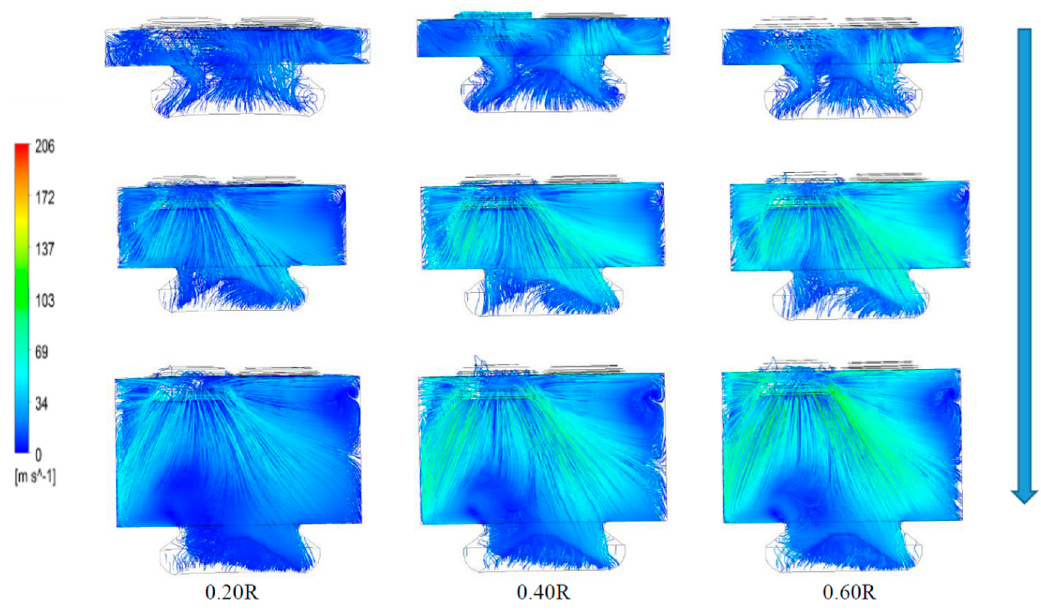
Figure 12. The computed streamline intake stroke crank angle at 30 ◦ ( top ), 60 ◦ ( middle ) and 90 ◦ ( bottom ) showing the swirl and tumble structure.